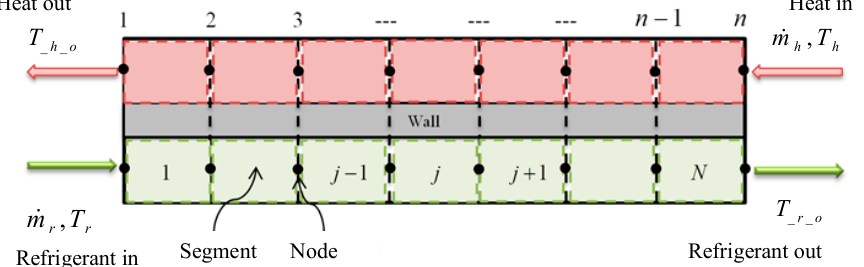
Figure 3. Finite volume (FV) discretization of evaporator.